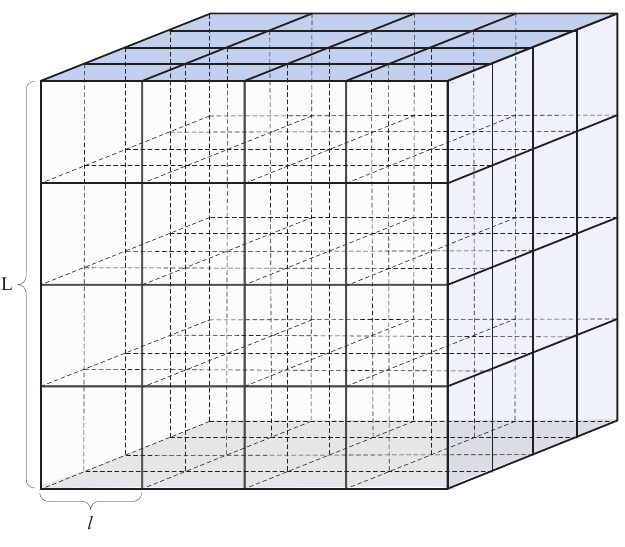
Figure 3. Network partition in GPN-LSCAN.